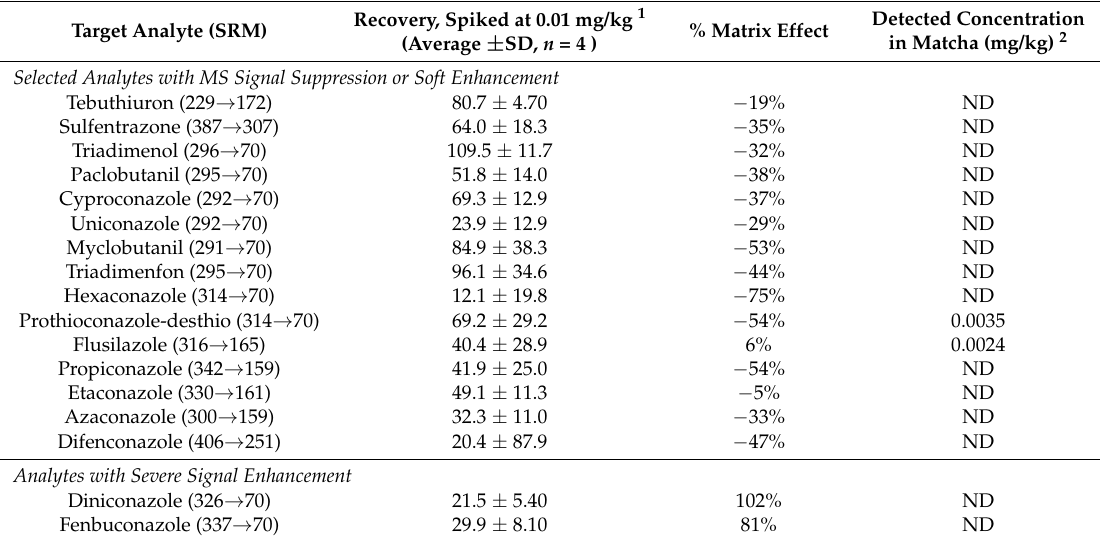
Table 2. Matrix Effect and Detected Concentration of Selected Fungicides in